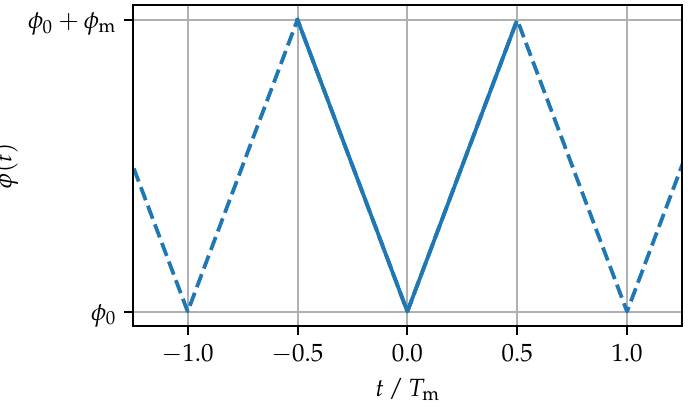
Figure 2. Phase φ modulation of the PS. Solid line: within one period T m , dashed line: outside the period.